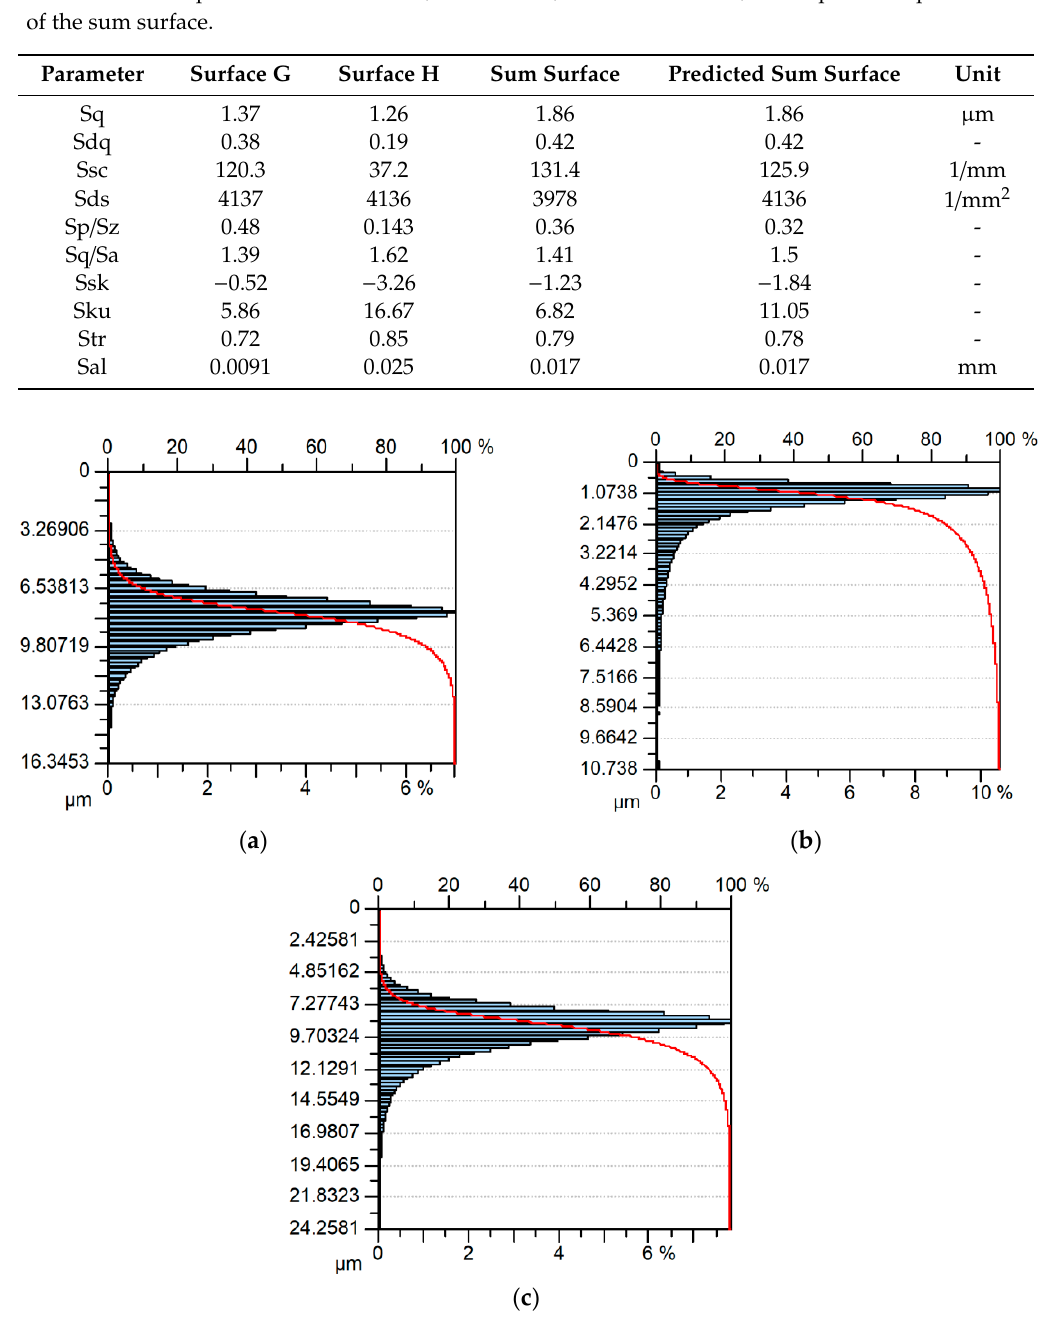
Figure 14. Material ratio curves and ordinate distributions of surface G ( a ), of surface H ( b ), and of equivalent sum surface ( c ).